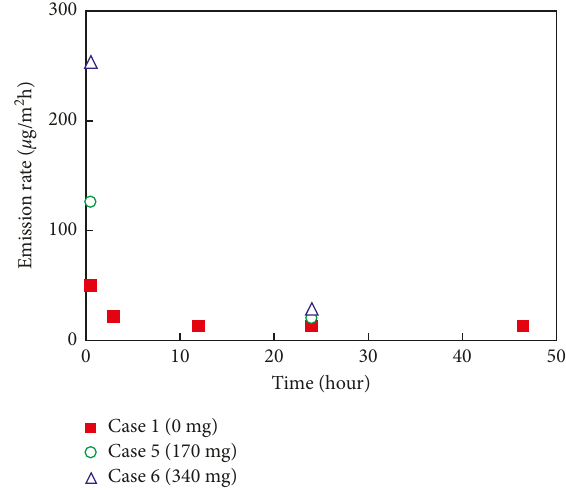
Figure 6: A plot of emission rate versus time showing the emission of DEHP from the flooring specimen with regard to airborne